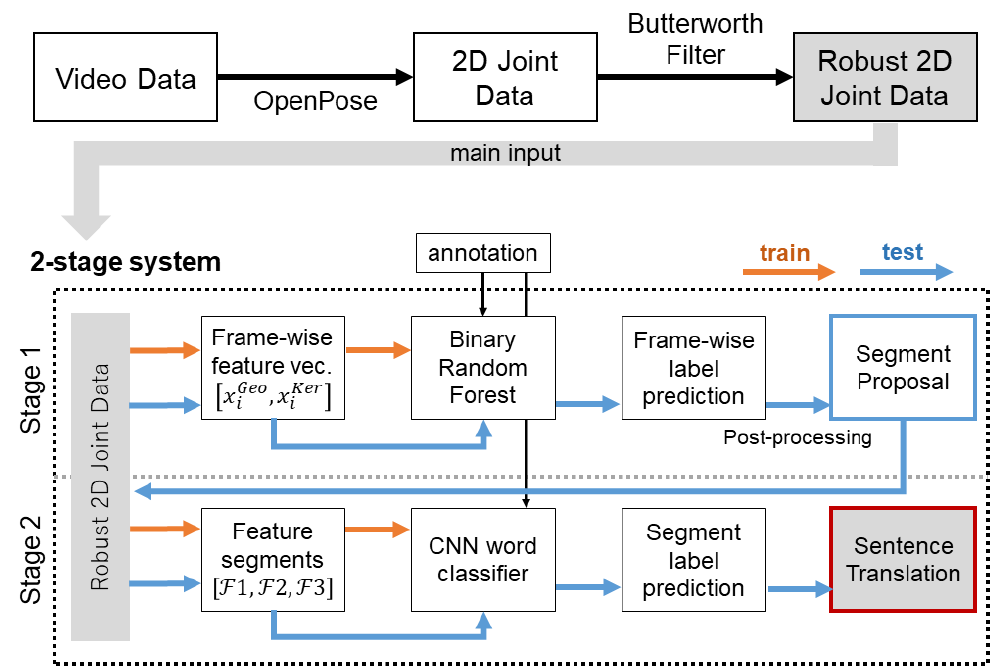
Figure 1. Overview of the complete system outline with the proposed two-stage recognition